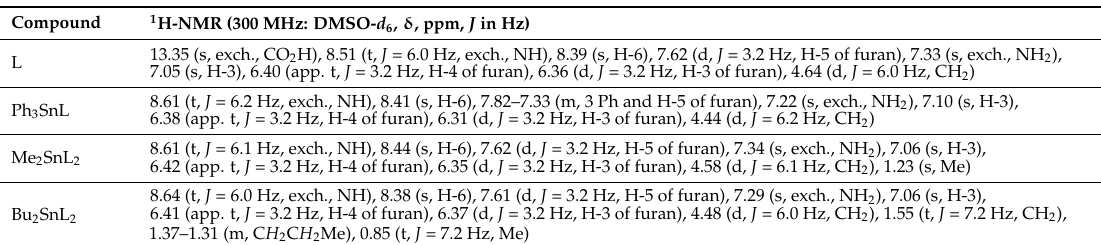
Table 4. 1 H-NMR spectral data for ligand and organotin